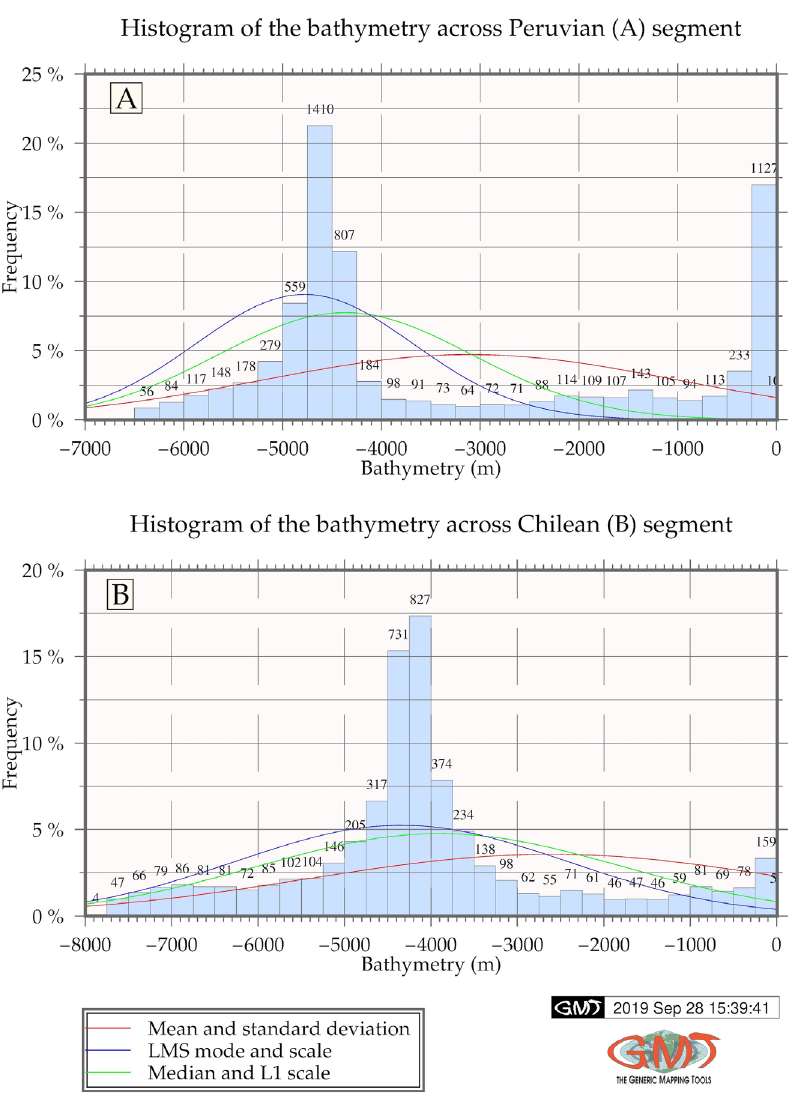
Fig 7. Histograms on the statistical analysis of the bathymetric data